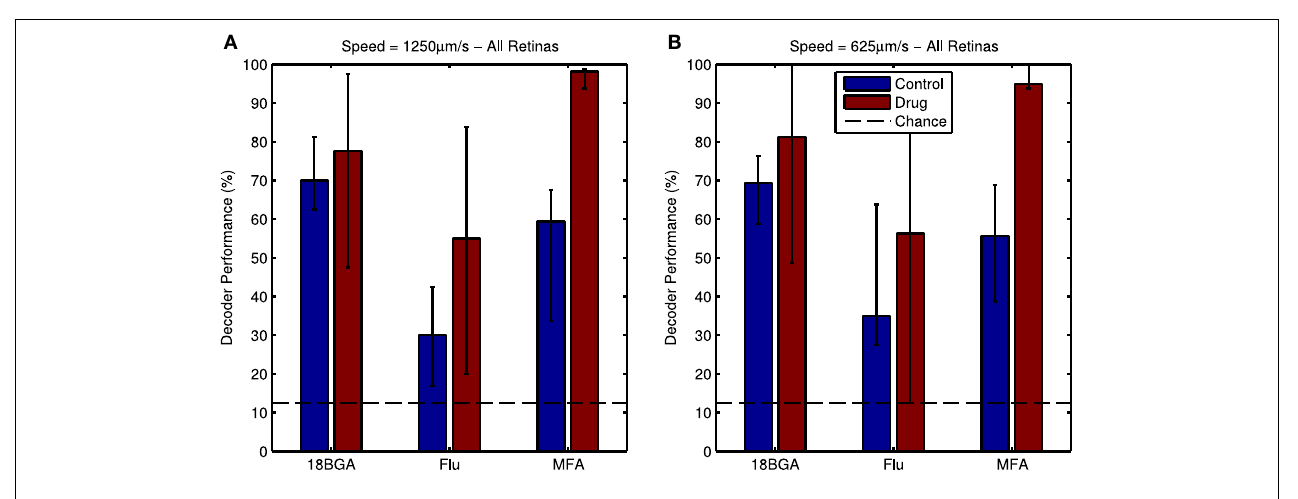
FIGURE 9 | (A) Bayesian decoder performance for responses to the 1250 µ m/s bars in control conditions (blue bars) and in the presence of 80 µ M of each drug (red bars). Decoder performance is much higher in the